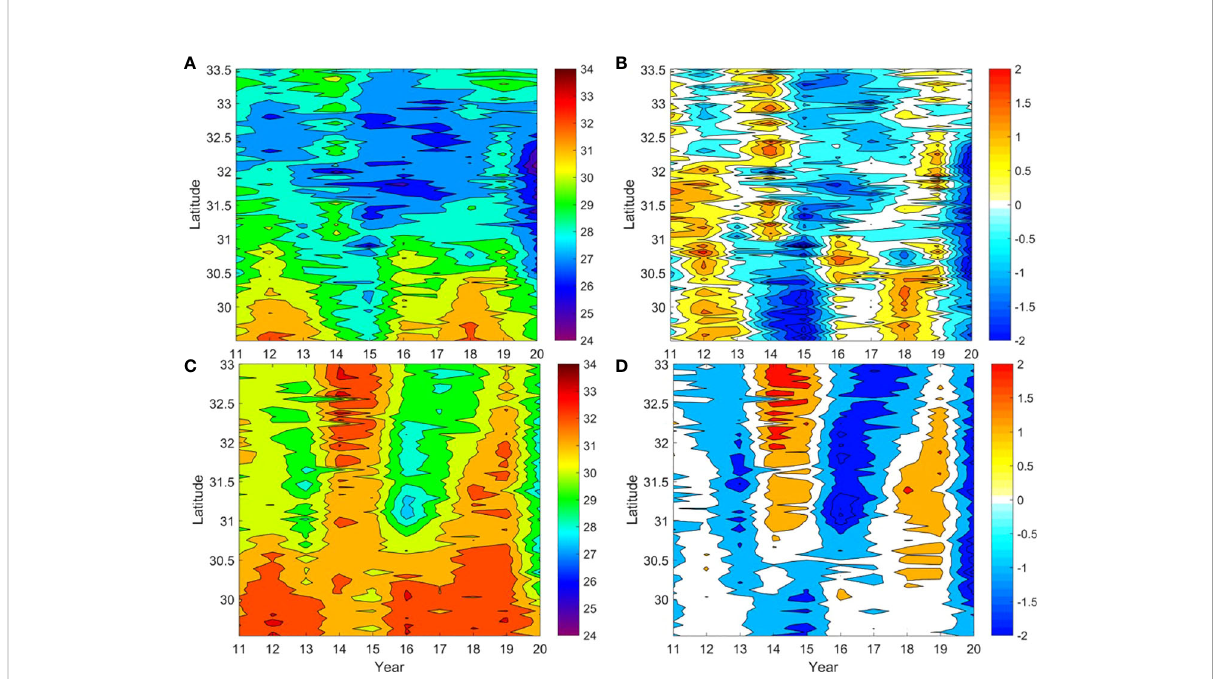
FIGURE 10 Time series of satellite-derived salinity (pus) (A, C) and anomalous salinity (B, D) . Mean values for August in the period 2011 – 2020 are shown along 125° E (A, B) and 127° E, (C, D) and from 29° N to 33.5° N, as a function of year and longitude. Mean and anomalous values are shown across years to emphasize the annual